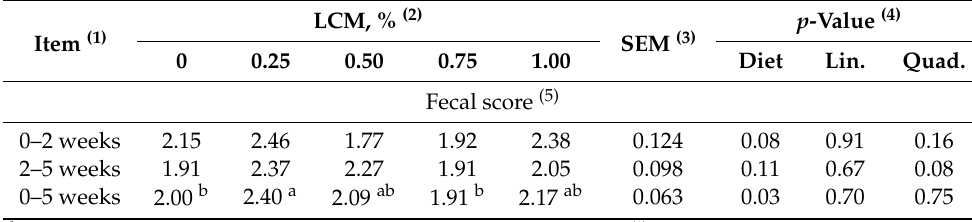
Table 7. Effects of LCM supplementation levels on fecal score in weaning pigs (exp.